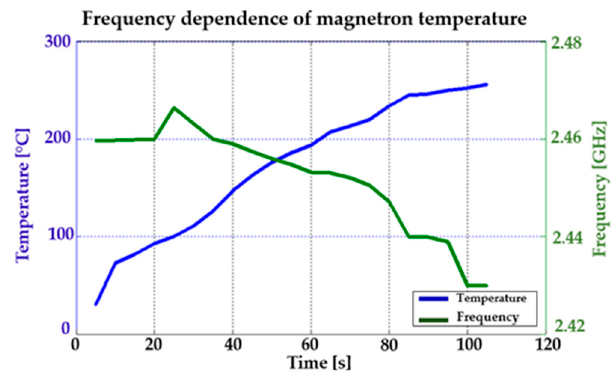
Figure 29. The effect of the magnetron’s frequency on the temperature of the magnetron. Figure 29. The e ff ect of the magnetron’s frequency on the temperature of the magnetron.